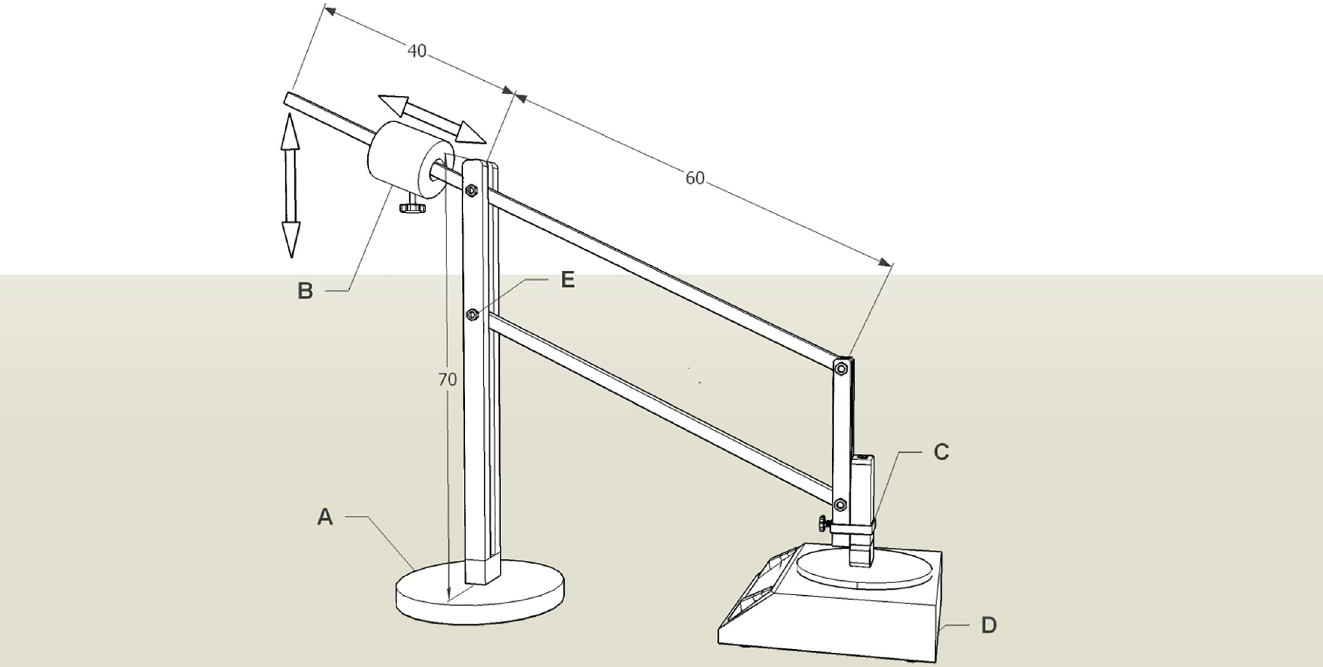
Fig 1. The CFAD was custom-made out of spruce wood. It consists of solid metal base (A), the wooden pylon, and horizontal swing-like handle. On one side of the handle, an iron weight (1200 g) is placed (B). The weight can be moved along the handle in order to change the required force application. The probe is fixed to the device with an adjustable plastic cluster (C). The positions of the weight corresponding to a desired force levels were determined and regularly checked by applying the load on a digital strain gauge-based scale (D). Ball-bearings (E) were used to connect the pylon with the swing.